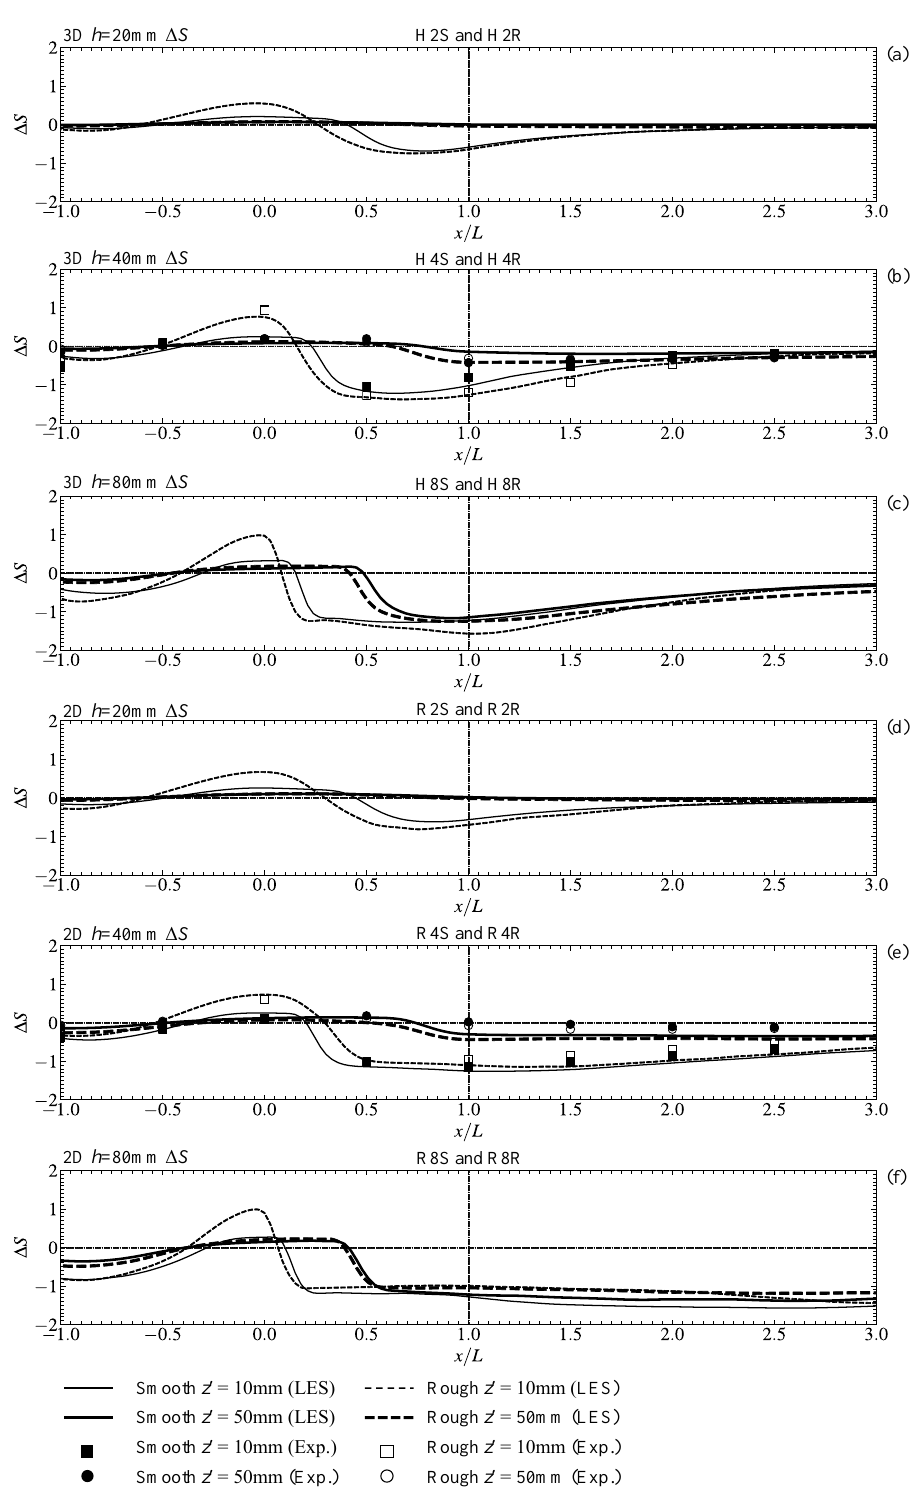
Figure 9. Fractional speed-up ratio ∆ S at z ′ = 10 mm and 50 mm, ( a ) 3D hills with h = 20 mm, ( b ) 3D hills with h = 40 mm, ( c ) 3D hills with h = 80 mm, ( d ) 2D hills with h = 20 mm, ( e ) 2D hills with h = 40 mm, and ( f ) 2D hills with h = 80 mm.